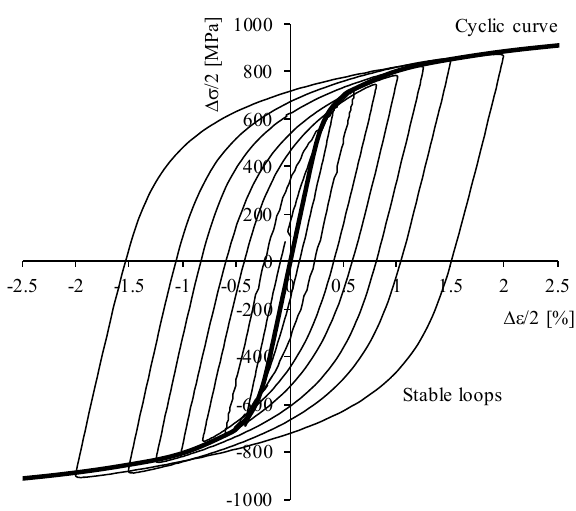
Figure 8. Cyclic stress ‐ strain curve obtained by connecting the tips of stable hysteresis loops for different strain amplitudes of the fully ‐ reversed strain ‐ controlled tests.